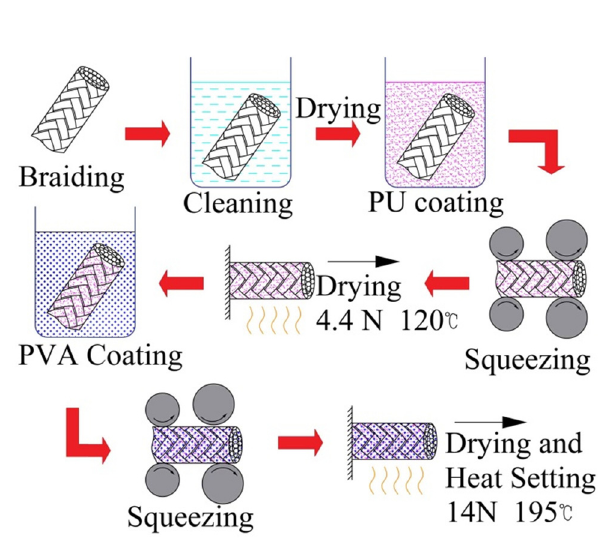
Figure 2: Manufacture of composite coated harness cord with PU/PVA.